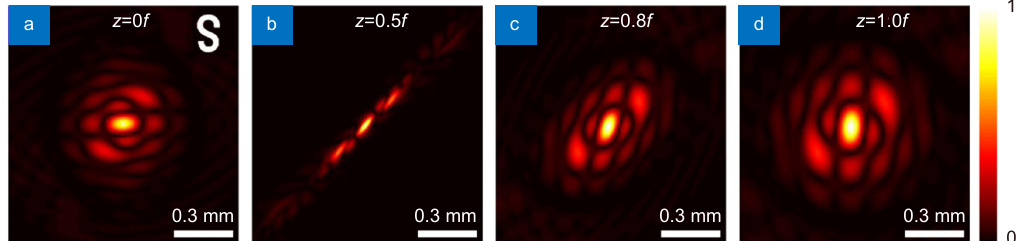
Fig. 2 | Theoretical results of the modulus of the DOC | μ | at different propagation distances z after the lens with the CP strength factor u =−60 mm −2 . The inserted letter “S” in (a) is adopted as the power spectral density P ( v )